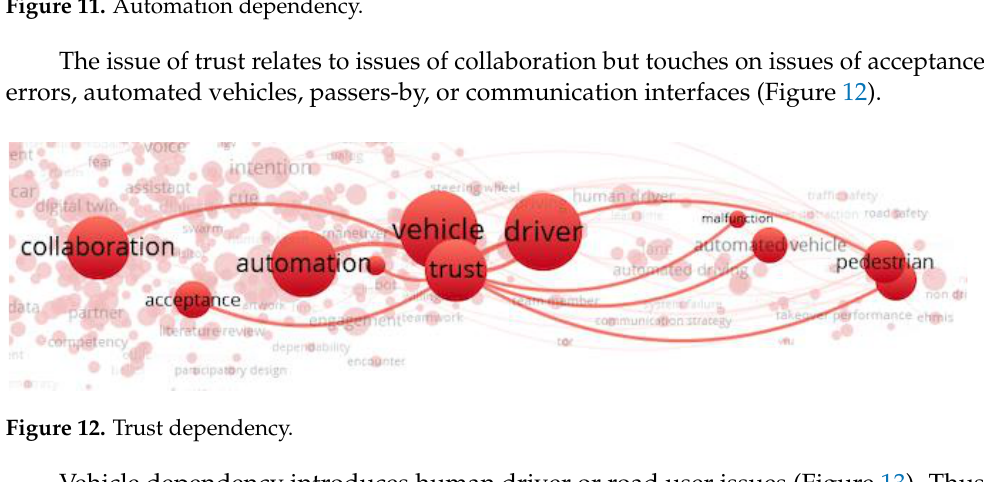
Figure 11. Automation dependency.